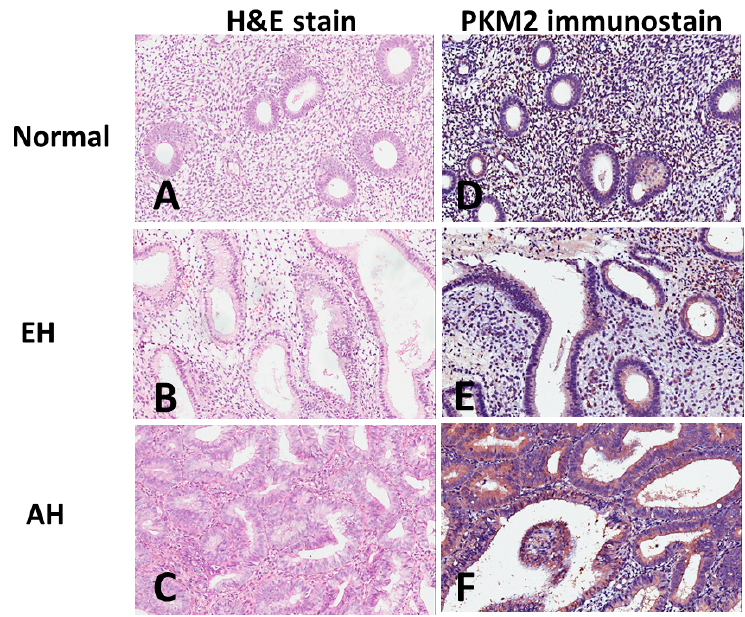
Figure 1. Examples of hematoxylin and eosin (H&E) staining of ( A ) normal endometrium, ( B ) endometrial hyperplasia without atypia, ( C ) atypical hyperplasia and pyruvate kinase M2 (PKM2) immunostaining of ( D ) normal endometrium, ( E ) endometrial hyperplasia without atypia, ( F ) atypical hyperplasia.